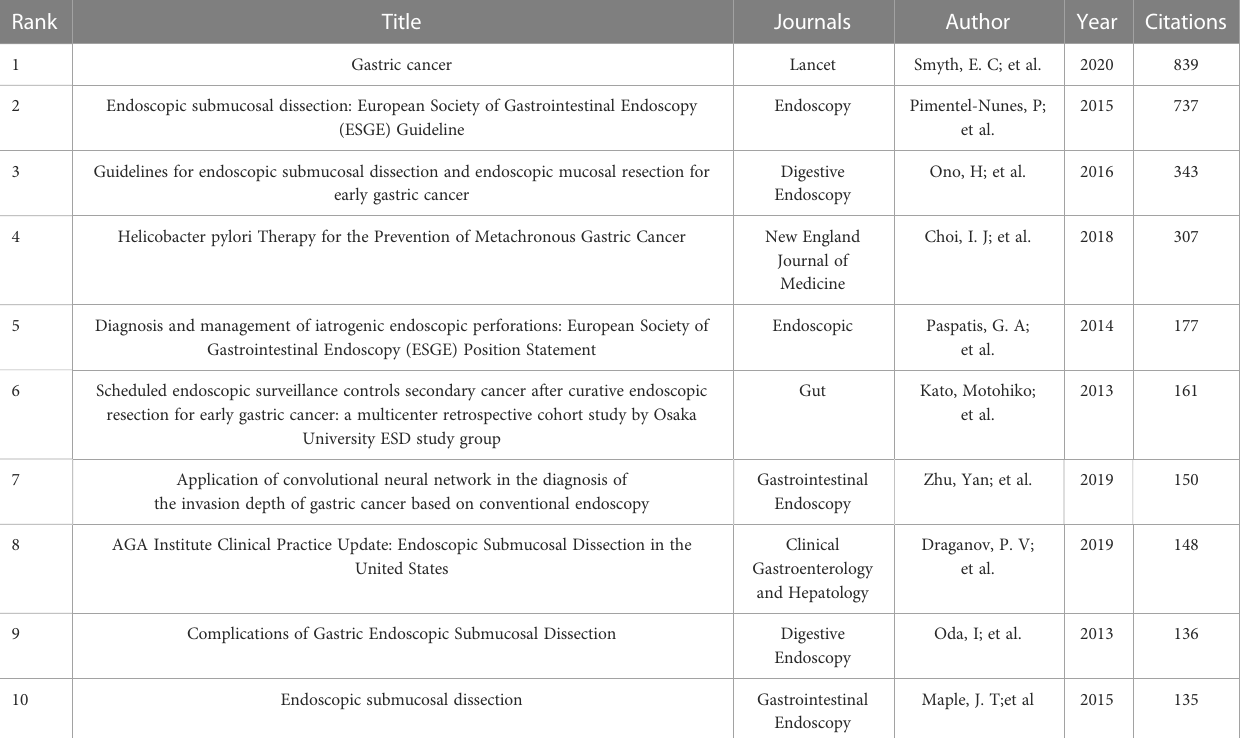
TABLE 5 Top 10 original articles related to endoscopic application in early gastric cancer.